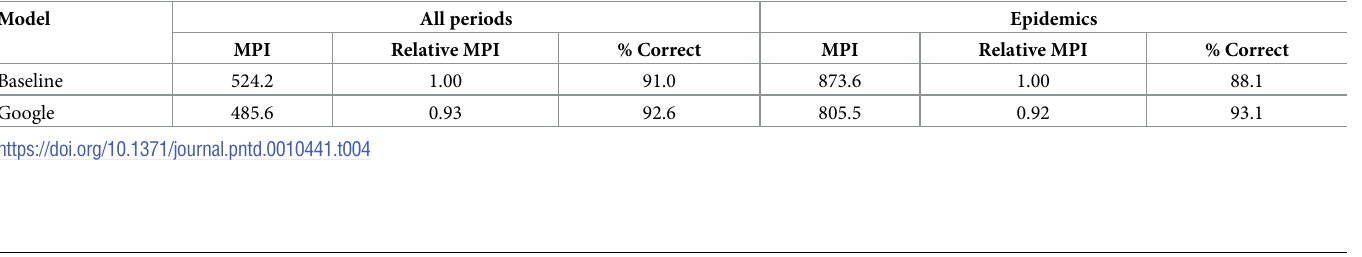
Table 4. Comparison of uncertainty in chikungunya case count estimates for the baseline nowcasting model and nowcasting model using Google searches. We com- pare the mean prediction interval widths (MPIs) for nowcasts from the baseline model and model using Google searches. The heuristic model is omitted as this approach does not allow a prediction interval to be calculated. The first three columns show results across the sample as a whole. The first column is the MPI reported in number of cases; the second column is the MPI relative to the baseline nowcasting model; and the third column is the percentage of actual weekly case counts within the prediction interval. The nowcasting model using Google searches is more precise than the baseline nowcasting model, reducing MPI by 7%. It is also slightly more reliable, capturing 93% of actual weekly case counts relative to 91% for the baseline model. In Table C in S1 Appendix, we show that the slight overconfidence of the prediction intervals is largely driven by the first epidemic, where the model had little data to train on. The final three columns show similar results when considering epidemic periods only. While the intervals are much wider for both models, the model using Google searches reduces MPI by 8%. The intervals produced by the model using Google searches are also even more reliable relative to the baseline during epidemics, capturing 93% of weekly case counts relative to